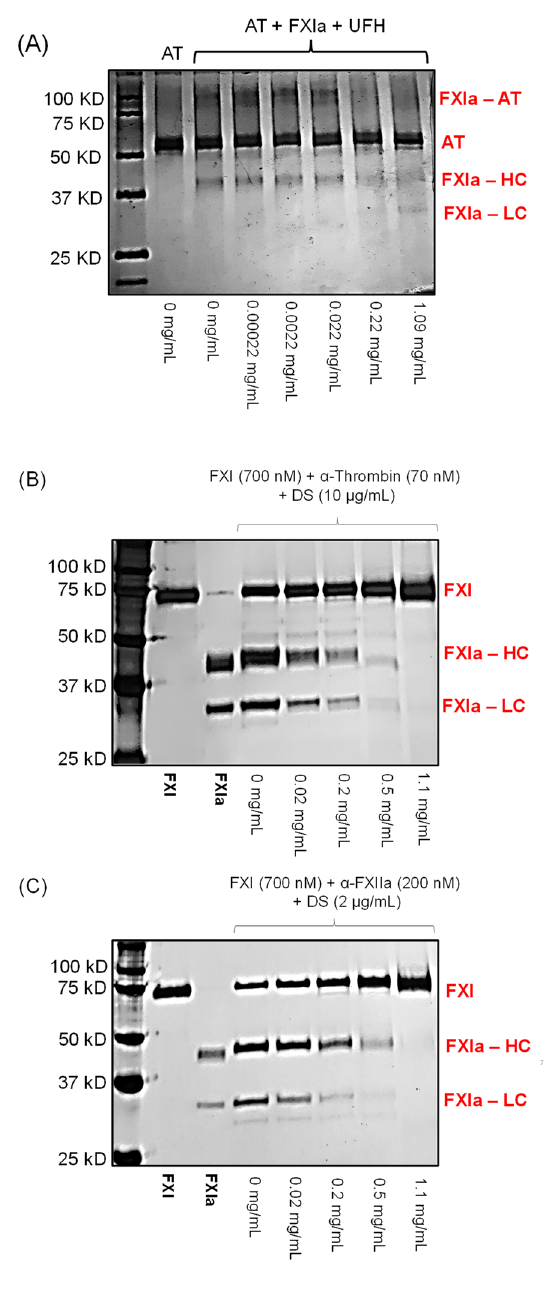
Figure 6. Effect of different concentrations of LSAS (0–1.1 mg/mL) on FXI(a) interactions with mac